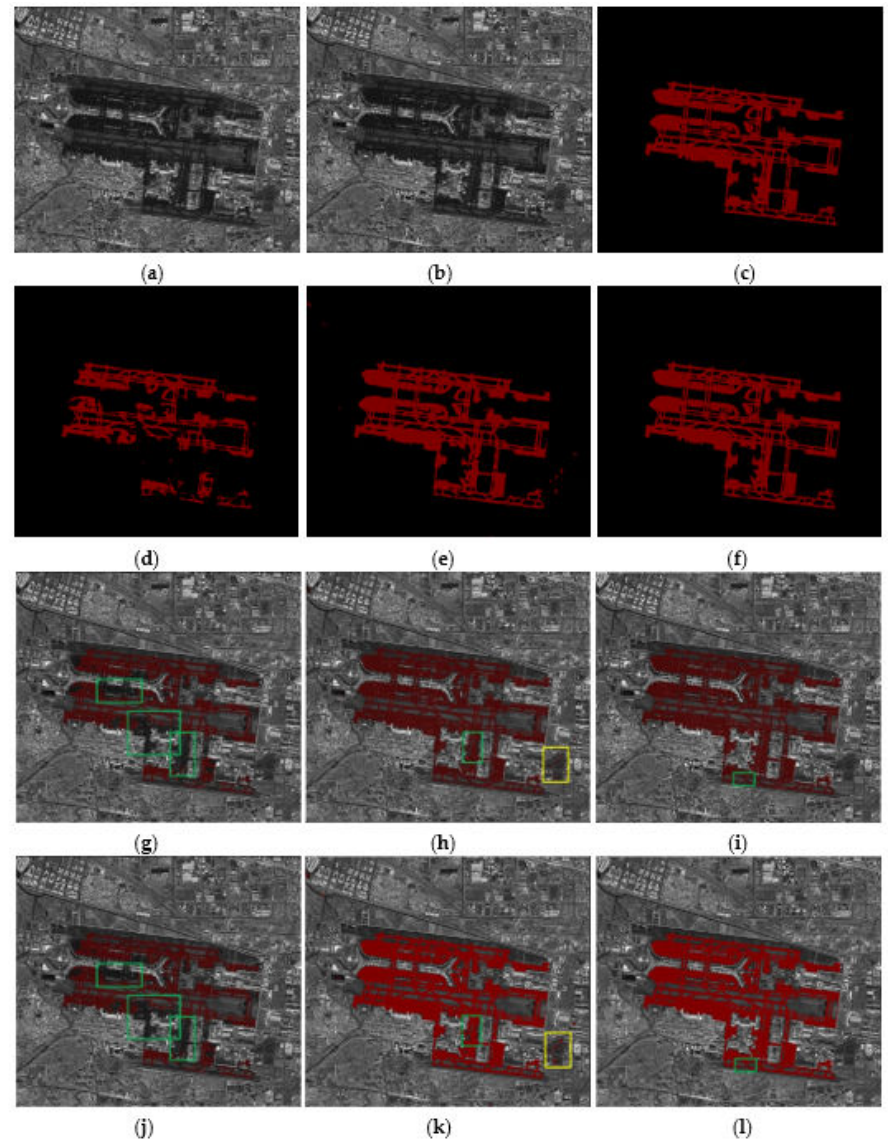
Figure 14. The experimental results for the horizontal flipped Airport I. ( a ) SAR image from Gaofen-3. ( b ) The down-sampled SAR image of ( a ) by 5 times. ( c ) The ground truth of the airport for ( b ). ( d ) The extraction result of ( b ) by RefineNet. ( e ) The extraction result of ( b ) by DeepLabV3. ( f ) The extraction result of ( b ) by MDDA. ( g ) The fusion map of ( d , b ). ( h ) The fusion map of ( e , b ). ( i ) The fusion map of ( f , b ). ( j ) The fusion map of ( a , d ) up-sampled by 5 times. ( k ) The fusion map of ( a ) and ( e ) up-sampled by 5 times. ( l ) The fusion map of ( a , f ) up-sampled by 5